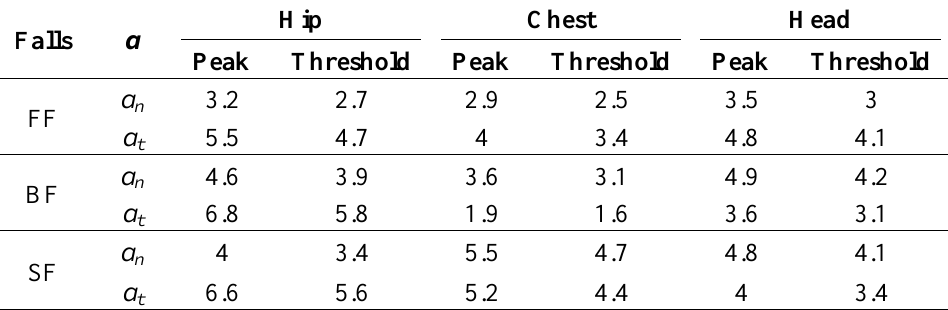
Table 4. Threshold accelerations (85% of the fall peaks) for hip, chest and head.